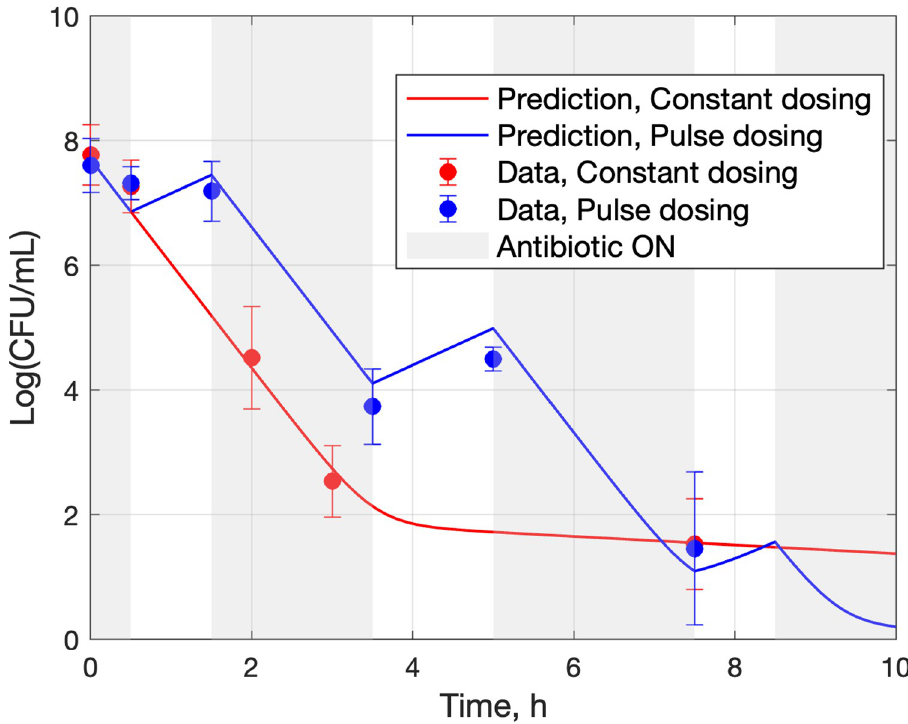
Fig 9. Outcome of non-uniform pulse dosing (and control) for non-uniform perturbations of pulse durations around their nominal values t on = 3h, t off = 2h.